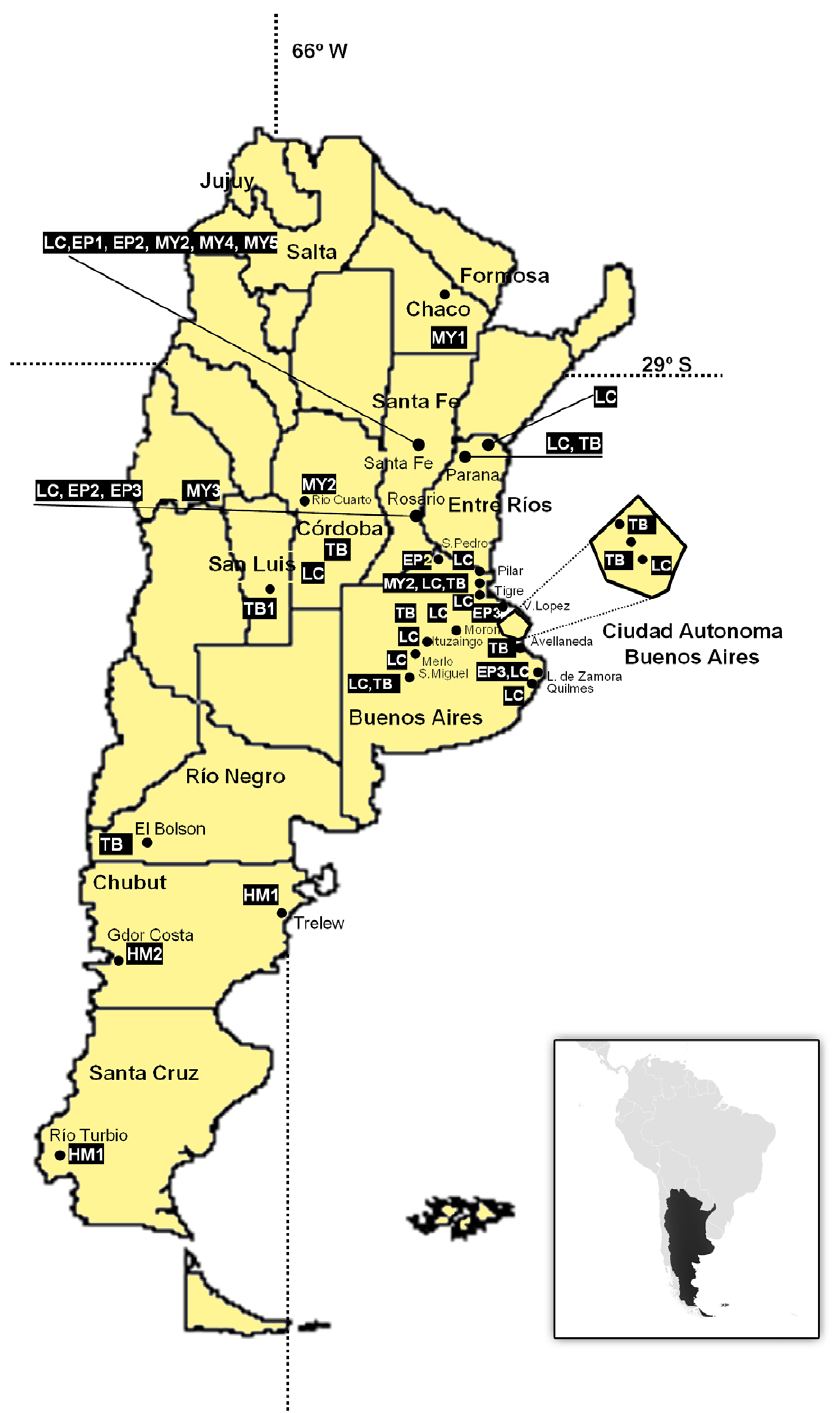
Figure 2. Geographic distribution of RABV sublineages associated with insectivorous bats from Argentina.